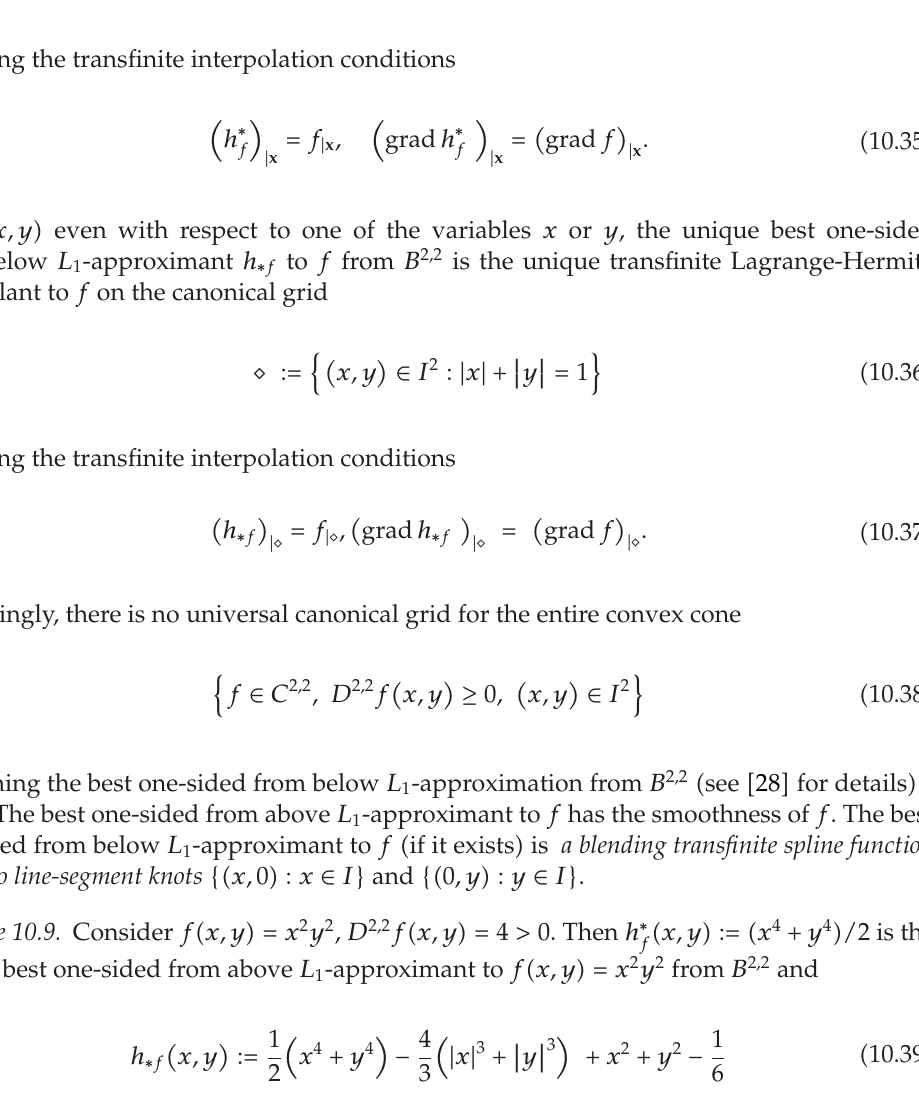
Figure 3 (cid:4) . Note that h ∗ / ∈ C 3 , 0 ∪ C 0 , 3 . Hence, the best one-sided from below L 1 -approximant from B 2 , 2 to f does not inherit the smoothness of f